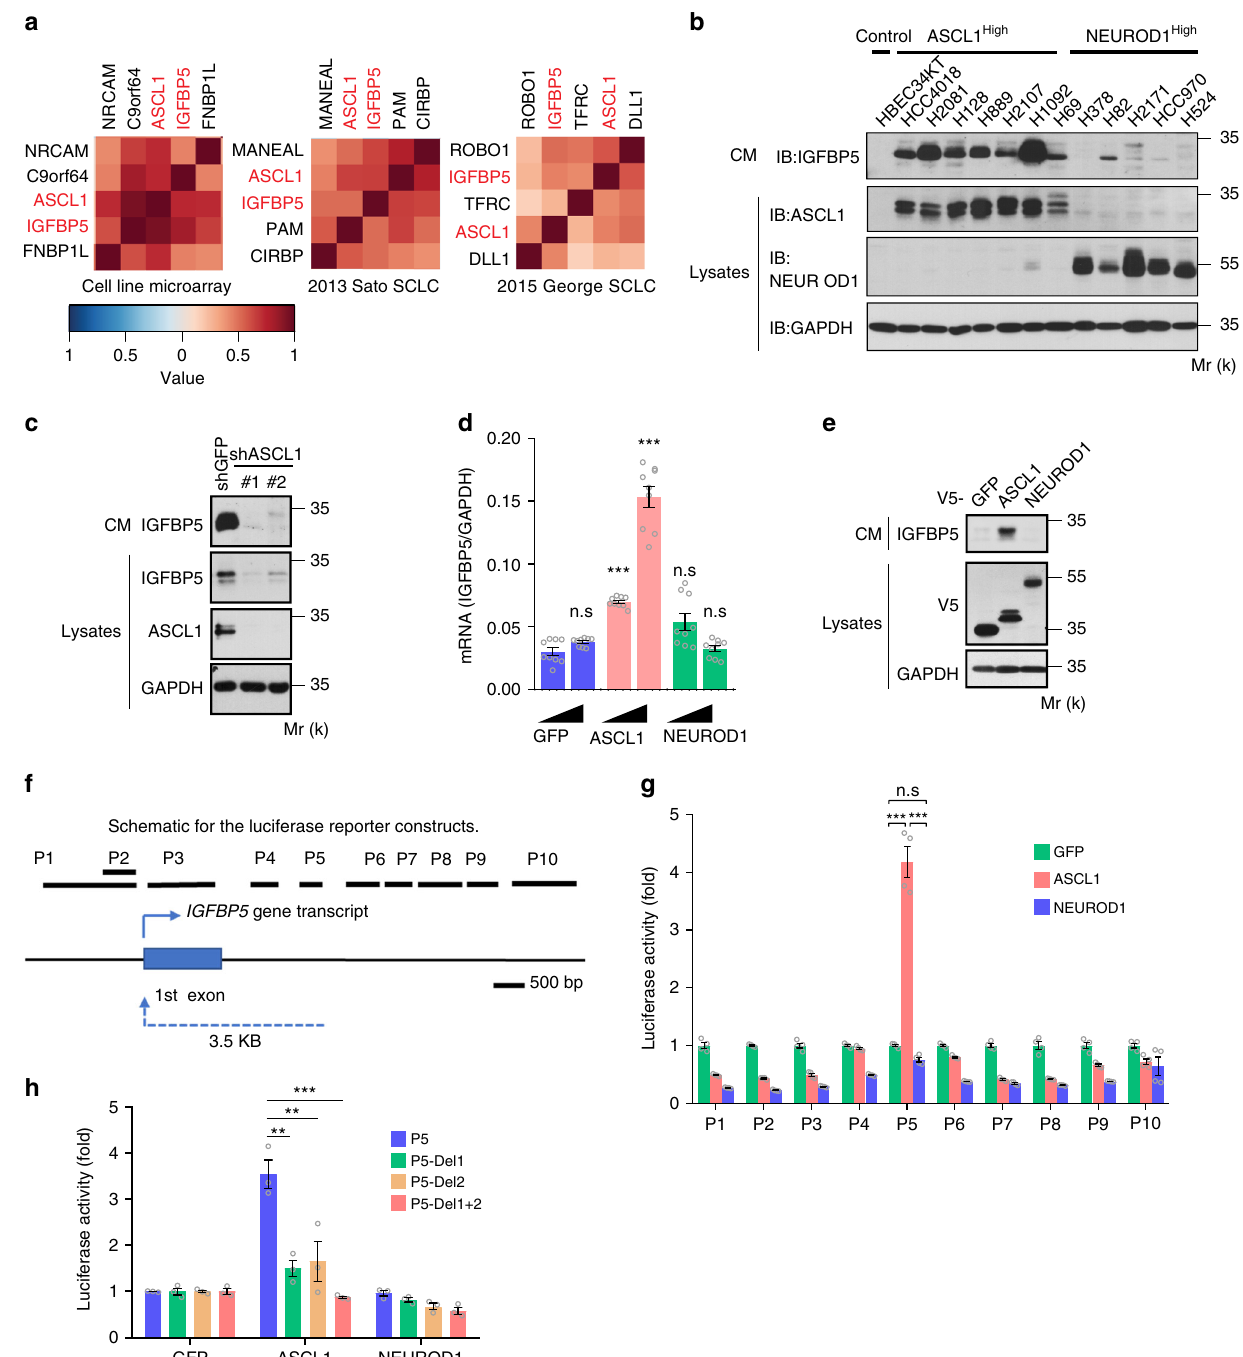
Fig. 4 Identi fi cation of IGFBP5 as a direct transcriptional target of ASCL1. a Correlation heatmap illustrating clustered matrix of top four genes with the highest similarities with ASCL1 based on the expression pro fi les from three independent SCLC transcriptomic datasets. b Western blot of IGFBP5 in the CM, ASCL1, and NEUROD1 in the lysates of the indicated cell lines (HBEC34-KT and NE-lung cancer cell lines). Molecular weight is indicated as Mr (k). c Immunoblotting analyses of the IGFBP5 levels in the CM and lysates of H2081 cells transduced with the indicated shRNAs. d , e RT-PCR ( n = 9, 3 independent experiments × 3 replicates) ( d ) and immunoblotting ( e ) analyses of IGFBP5 expression in HEK293T cells transfected with the indicated expression constructs. f Schematic for the various IGFBP5 luciferase reporter constructs. g Luciferase activity analysis of HEK293T cells transfected with the indicated IGFBP5 luciferase reporter constructs, together with V5-tagged GFP, ASCL1, or NEUROD1 ( n = 4 replicates). h Luciferase activity of HEK293T cells transfected with the indicated deletion mutants of IGFBP5 luciferase reporter constructs, together with V5-tagged GFP, ASCL1, or NEUROD1 ( n = 3 replicates). Unpaired two-tailed t -test. ** P < 0.01, *** P < 0.001, n.s not signi fi cant. Error bars represent mean ± standard error of mean (s.e.m.). Source data are provided as a Source Data fi